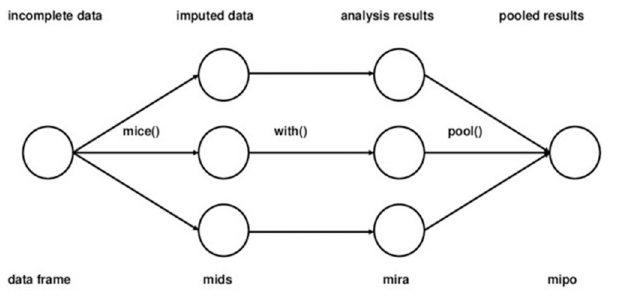
Fig 1. Main steps used in multiple imputation